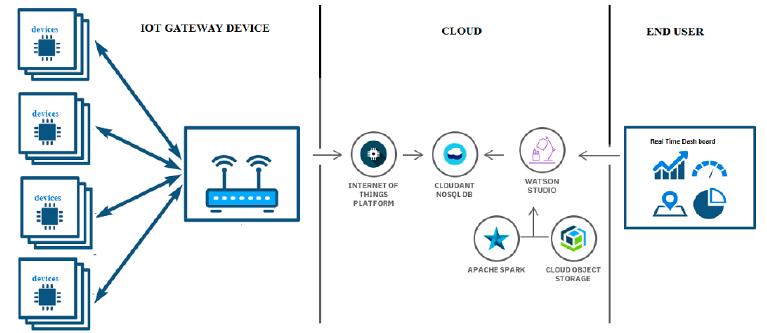
Figure 8. IoT architecture employing cloud services.